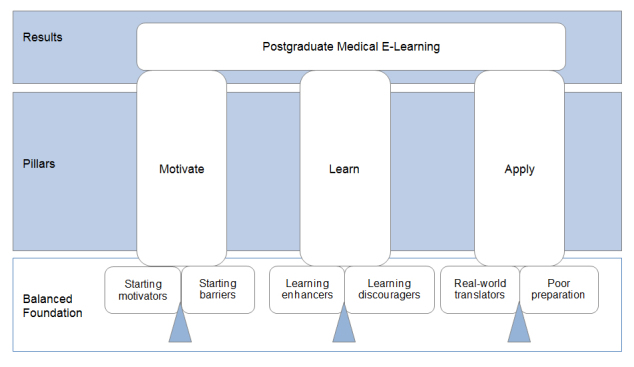
The final theme